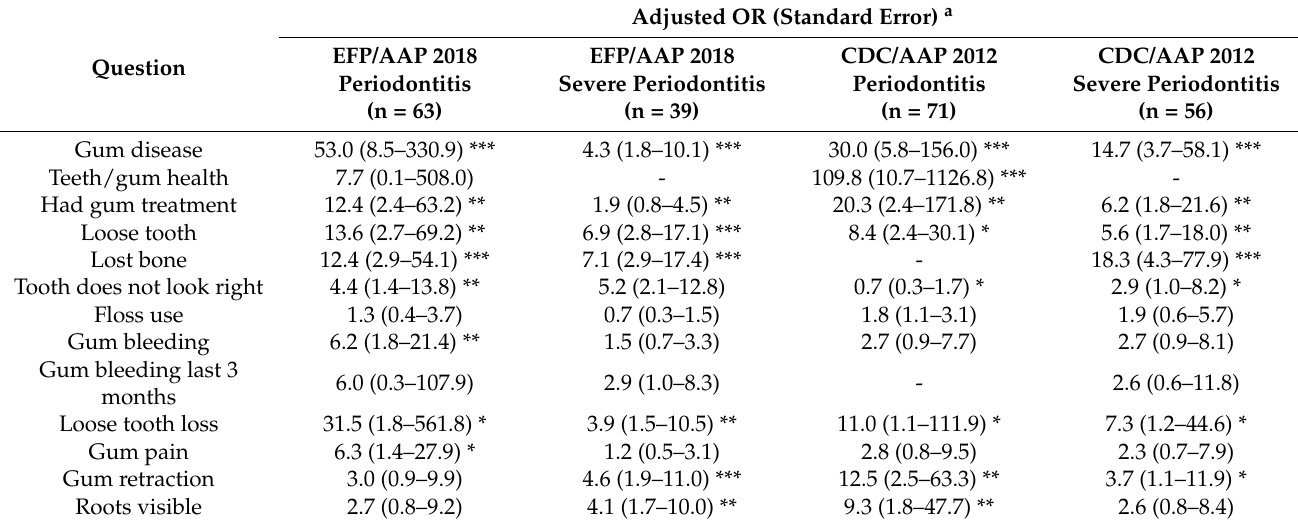
Table 3. Adjusted odds ratio (OR) for each of the four periodontitis outcomes.